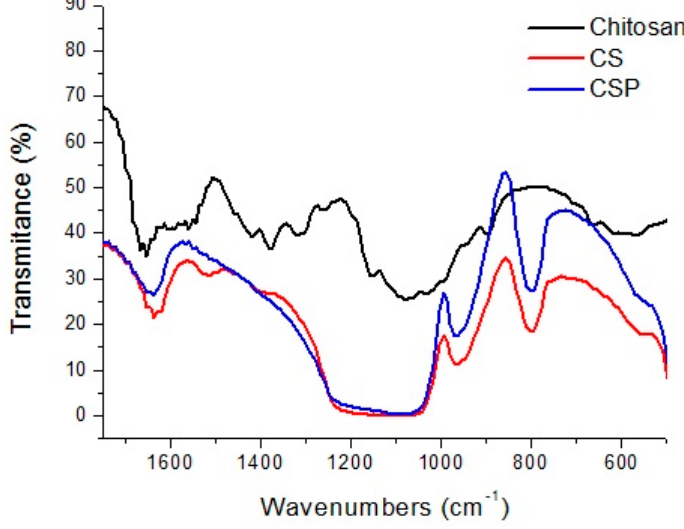
Figure 1. Infrared Spectra for CS and CSP adsorbents.